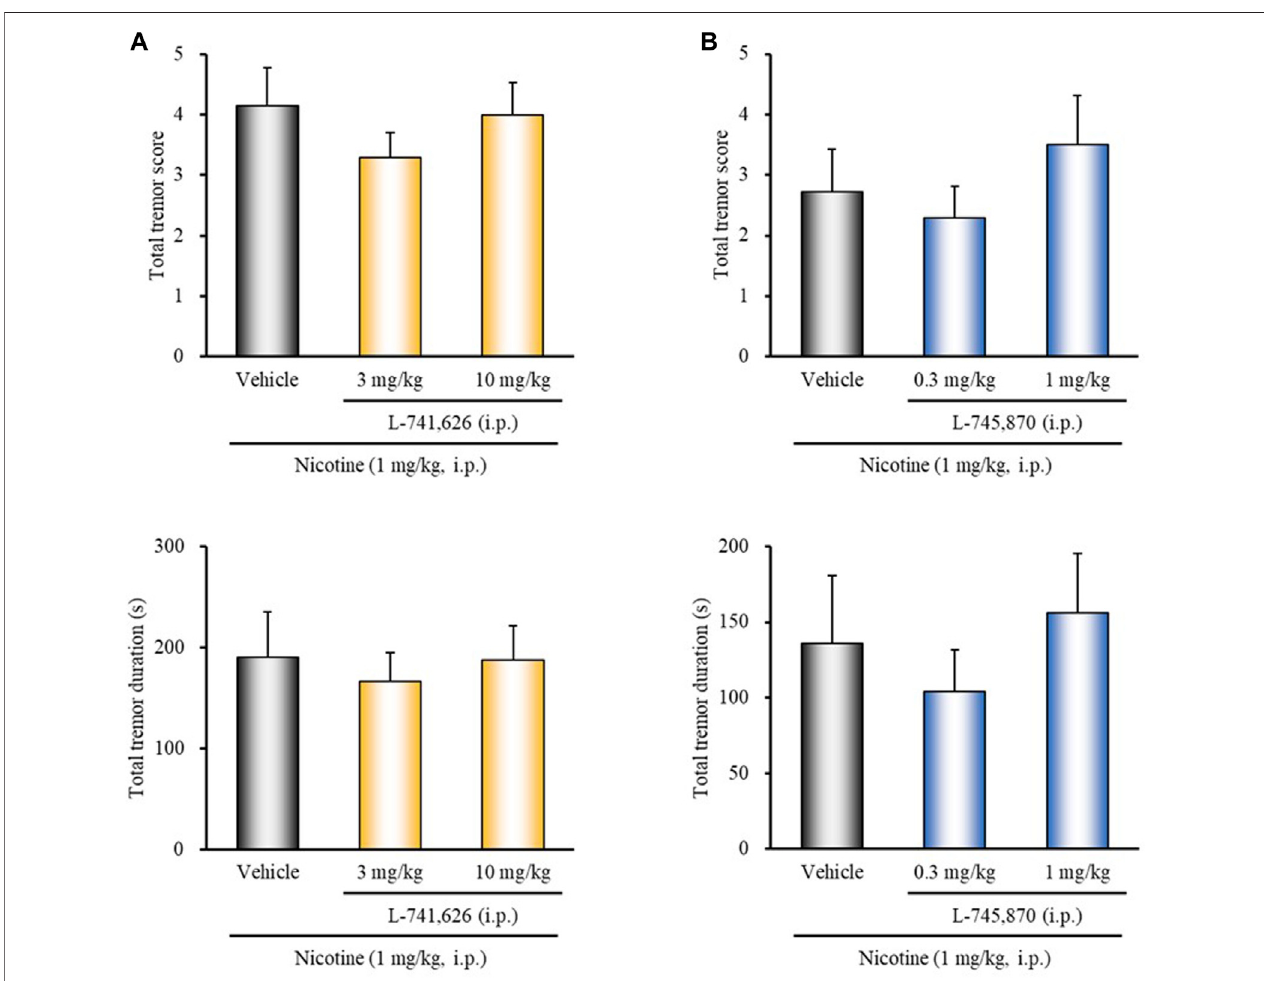
FIGURE3| EffectsofD 2 orD 4 receptorantagonistsonnicotine-inducedtremorinmice.Miceweretreatedwith: (A) theD 2 antagonistL-741,626(3,10 mg/kg,i.p.), (B) theD 4 antagonistL-745,870(0.3,1 mg/kg,i.p.),orvehicle(control)15 minbeforethenicotine(1 mg/kg,i.p.)injection.Datashowthetotaltremorscore(intensity)and duration of nicotine-induced tremor over the 10 min observation period. Each column represents the mean ± S.E.M.